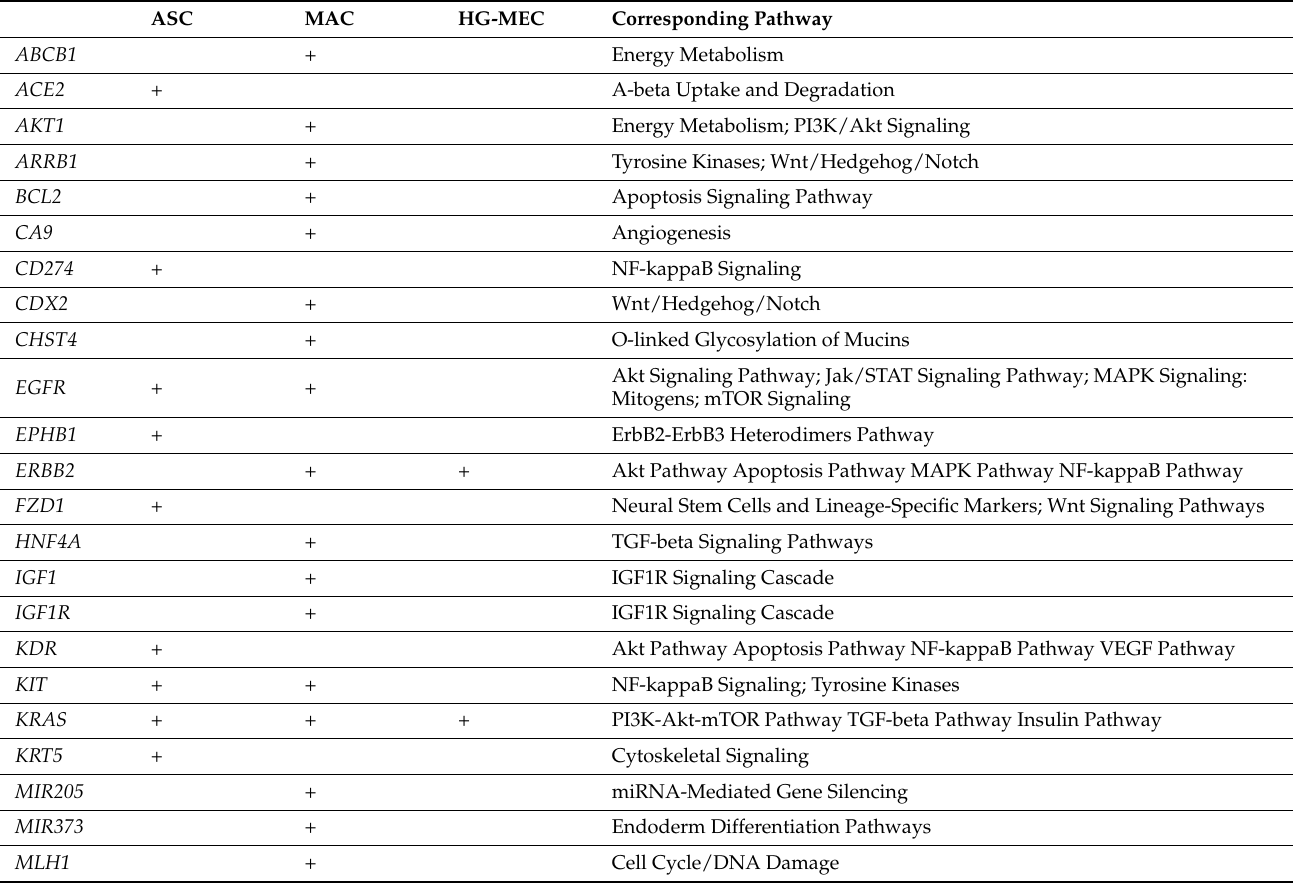
Figure 7. Genetic network analysis of MACs. Table 2. ASCs, MACs, and HG-MEC mutated genes and corresponding